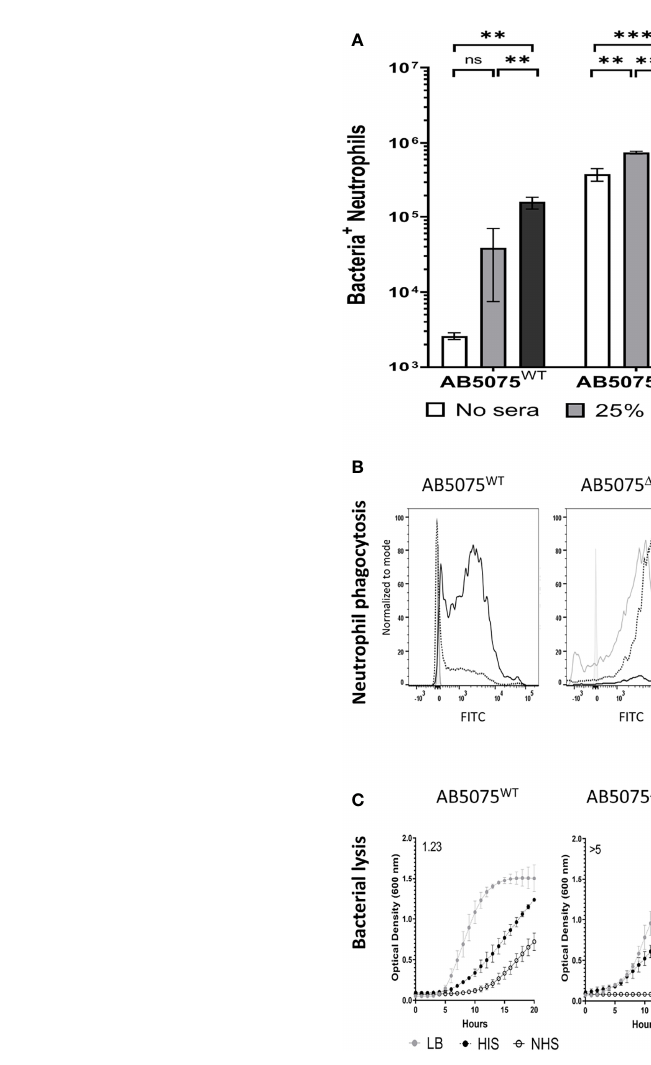
FIGURE 2 | Human complement enhances neutrophil phagocytosis of wild-type and unencapsulated AB5075 isolates. FAMSE labelled encapsulated AB5075 WT and unencapsulated AB5075 D wza and AB5075 D ptk strains were opsonized with either 25% heat-inactivated human sera, 25% normal human sera or unopsonised (PBS only) and incubated with healthy human neutrophils at Bacteria: Neutrophil MOI of 100:1. (A) Shows the percentage of FAMSE +ve Neutrophils multiplied by the MFI of FAMSE +ve Neutrophils [Mean (± standard deviation)] on the Y axis. Phagocytosis indices in unopsonised bacteria or those incubated with heat-inactivated sera, or normal sera for each isolate is represented in the white, grey and black bars respectively. (B) Representative histograms showing phagocytosis of FAMSE labelled A. baumannii isolates incubated with either normal sera, heat-inactivated sera, or PBS only. Each graph shows a solid grey histogram that represents neutrophils only (no bacteria), open grey histogram represents phagocytosis of unopsonised bacteria, black-dotted line represents phagocytosis of HIS opsonized bacteria and black solid fi lled histogram line represent bacteria opsonized with NHS. (C) Growth curves showing bacterial OD 600nm measurements over 24 hours obtained from bacteria incubated with either LB broth (grey circle), heat-inactivated sera (black circles) or normal human sera (open circle). Numbers on the top left corner indicate the doubling time ratio. The doubling time for each condition/strain was calculated to compare the growth rates of the three strains. Lower doubling times were observed in AB5075 WT compared to either AB5075 D wza or AB5075 D ptk in LB and HIS. Similarly, lower doubling times were observed in AB5075 D ptk compared to AB5075 D wza . The lack of detectable bacterial growth in NHS for AB5075 D wza and AB5075 D ptk prevented comparisons between strains analyses condition. Bars represent mean values for each condition/strain and the error bars indicate standard deviations (SDs) (n=3). T-test was used for statistical analysis *: p-value < 0.05, **: p-value < 0.01, ***: p-value < 0.001, ns: p-value > 0.05. Representative data from three independent experiments is